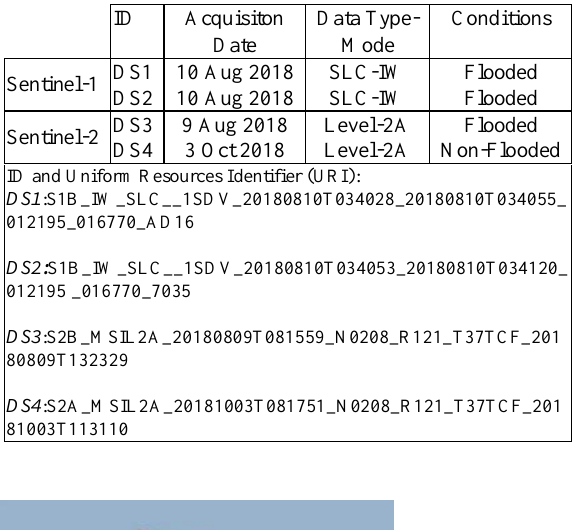
Table 1. Basic specifications of the Sentinel-1 and Sentinel-2 datasets used in the study.